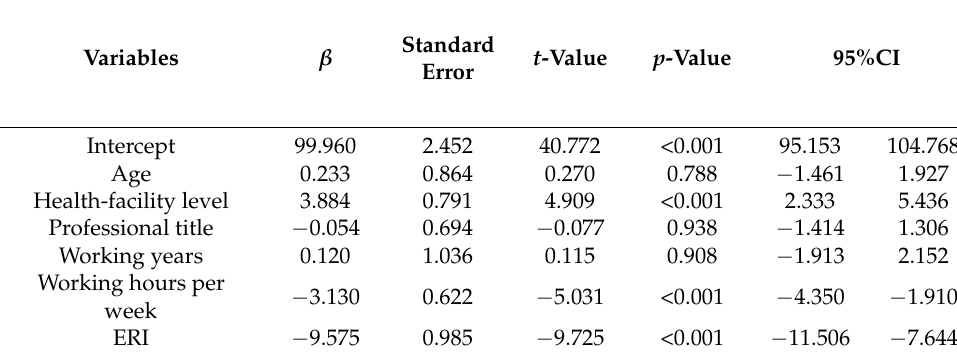
Table 7. Exploration of factors influencing the mental health of medical staff.